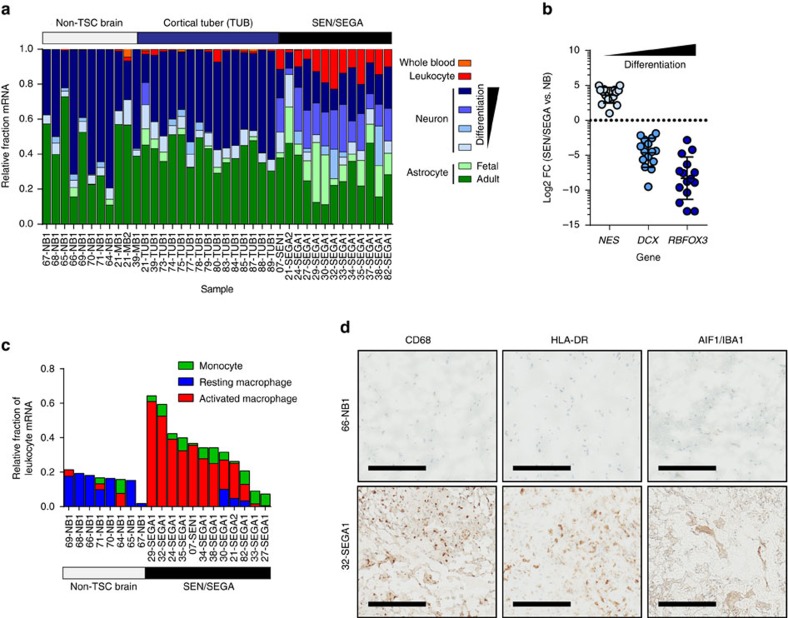
Immune response is observed in TSC brain lesions.(a) Relative fraction of cell types estimated by CIBERSORT (P<0.05). Orange: whole blood; red: leukocytes; dark blue: differentiated neuron; light blue: undifferentiated neuron; light green: fetal astrocyte; dark green: adult astrocyte. (b) Fold-change in transcript abundance in SEN/SEGA compared to non-TSC brains for three markers of neuronal differentiation. Lines: means; error bars: s.d. (c) Relative fractions of 22 immune cell types estimated by CIBERSORT. Those significantly enriched in SEN/SEGA compared to NB (FDR-adjusted P<0.05) are displayed as their relative fraction of leukocyte RNA per sample. (d) Fresh-frozen tissue sections from NB and SEGA were immunostained for CD68 (macrophages), HLA-DR (MHC-Class II) and AIF1/IBA1 (microglia). 66-NB1 and 32-SEGA1 are shown. Scale bars, 200 μM.